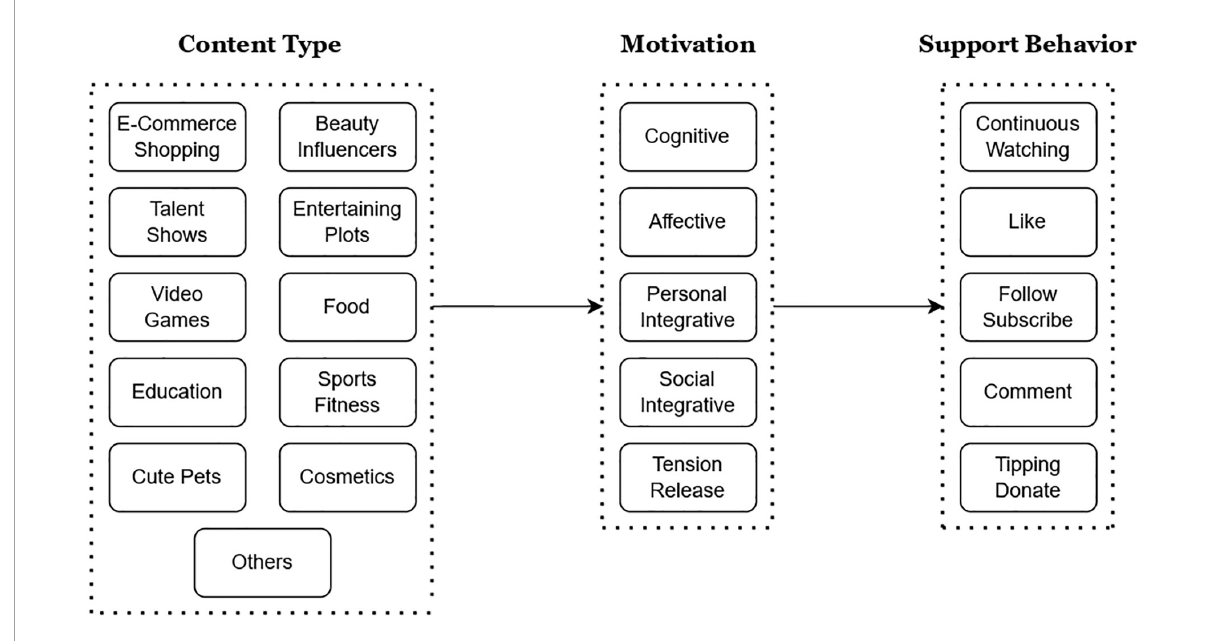
FIGURE1 Conceptual research